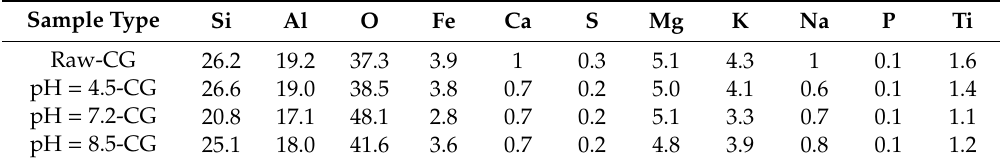
Table 6. Content of each element by XRF /